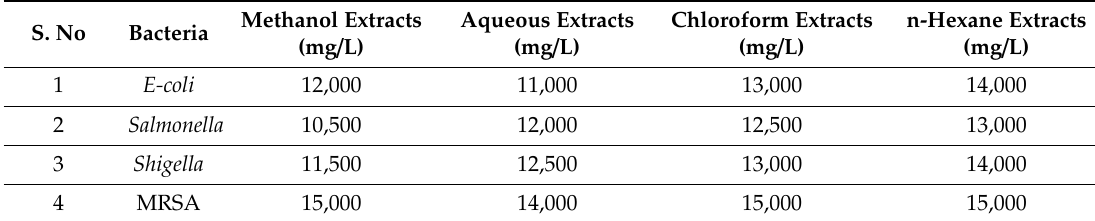
Table 7. Minimum inhibitory concentration (MIC) of recipe 2 against di ff erent bacterial